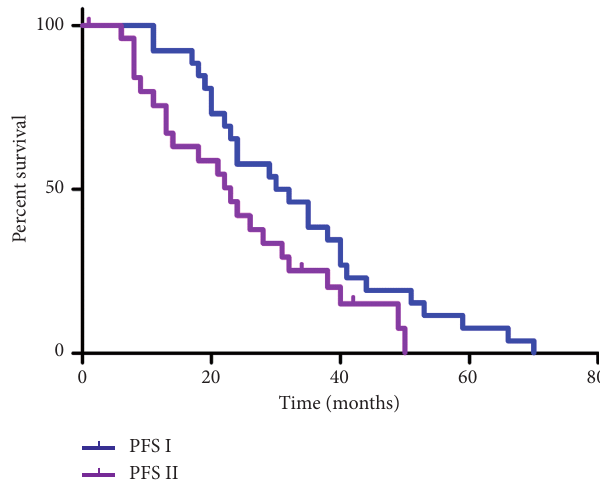
Figure 2: Tandem [ 90 Y]Y/[ 177 Lu]Lu-DOTATATE therapy: Kaplan–Meier estimators of the progression-free survival after the initial PRRT (PFS I) in relation to the progression-free survival after the repeated PRRT (PFS II).